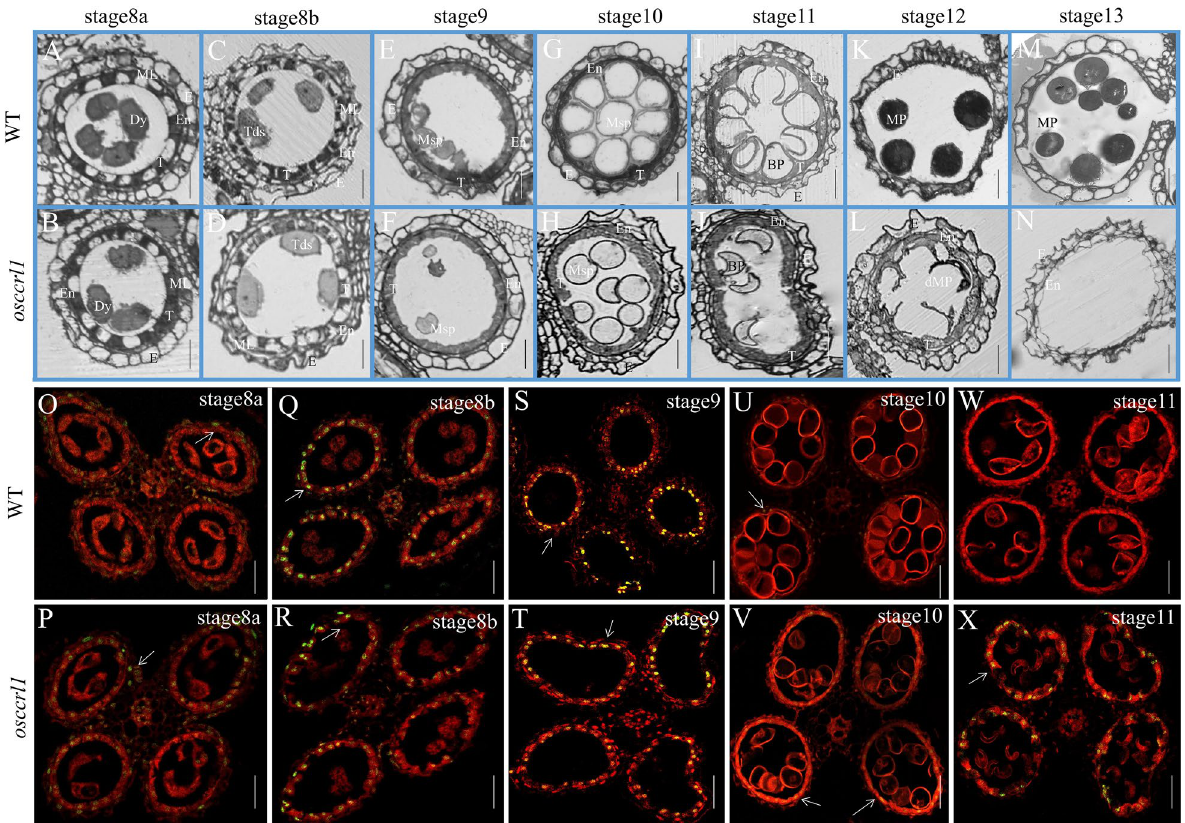
Fig. 2 Semi-thin section and TUNEL assay of the wild type and osccrl1 mutant. A type and osccrl1 mutant. The images show a single locule of an anther. E, epidermis; En, endothecium; M, middle layer; T, tapetum; Dy, dyad cell; Tds, tetrads; Msp, microspore; BP, bicellular pollen; MP, mature pollen; dMP, mature pollen. Scale bars, 25 μm. O osccrl1 anthers at stages 8a to 11. Propidium iodide staining is indicated by red fluorescence and TUNEL positive staining is indicated by yellow to green fluorescence (arrow indication). Scale bars, 100